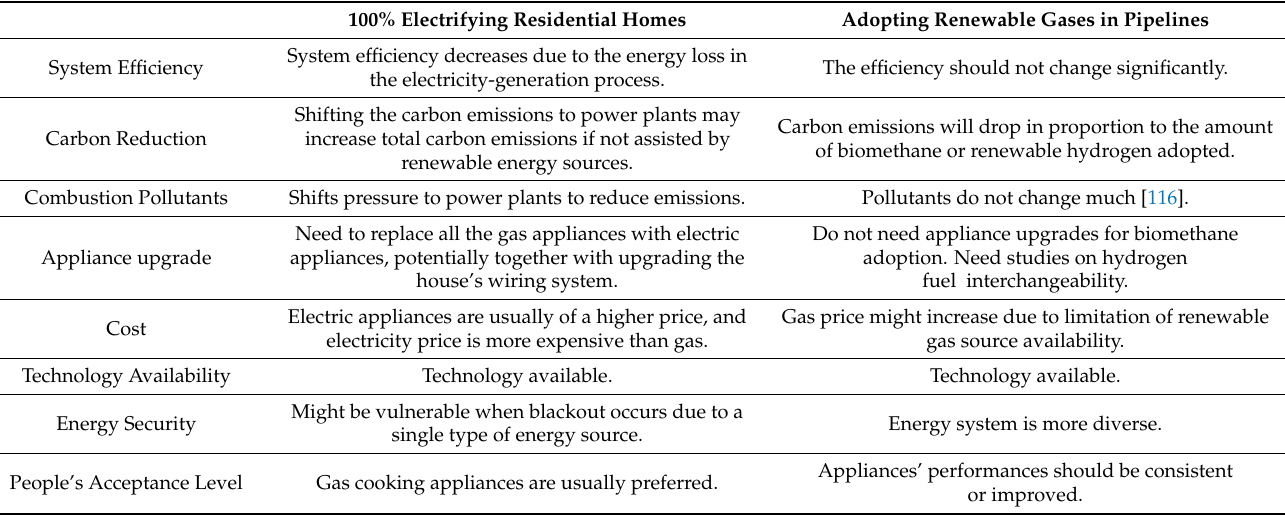
Table 11. Comparison between electrifying residential homes and adopting renewable gases in residential